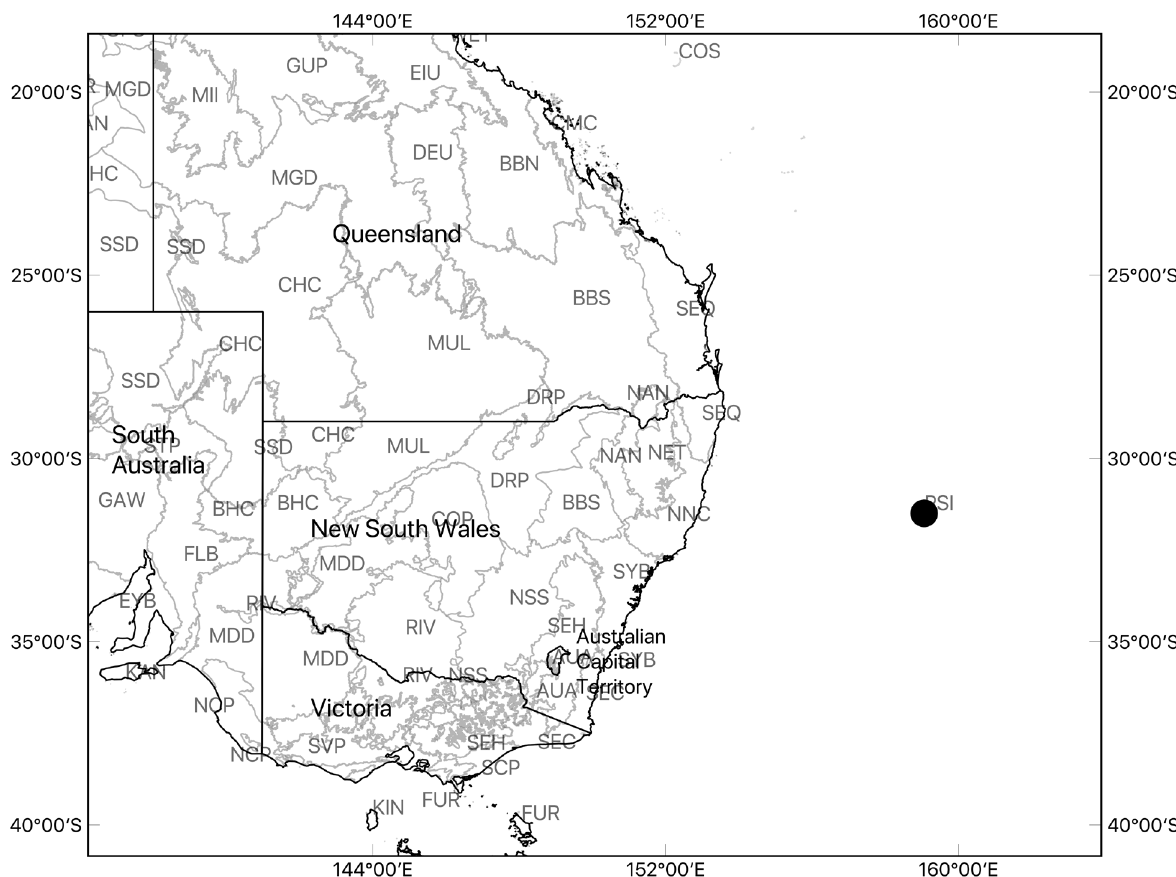
Figure 21. Distribution records of Artoria gloriosa (Rainbow, 1920) (full circle) in NSW. IBRA bioregions with spider records: PSI – Pacific Subtropical